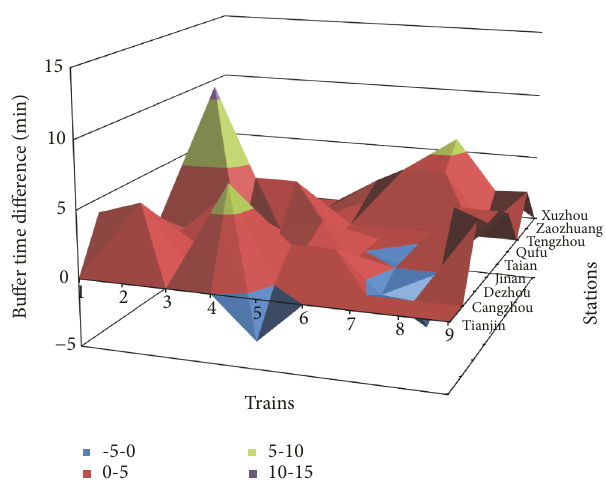
Figure 12: The difference of the buffer time between the original timetable and adjusted timetable.